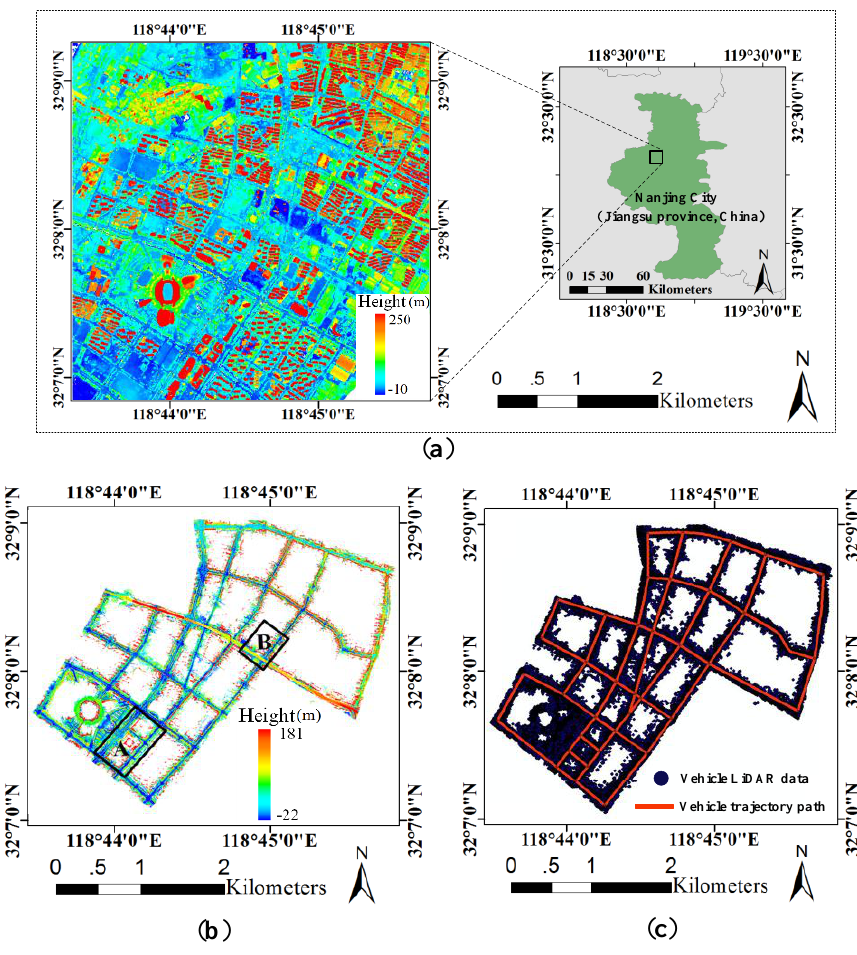
Figure 7. Experimental data. ( a ) Airborne LiDAR data; ( b ) Vehicle LiDAR data; ( c ) Vehicle trajectory path.